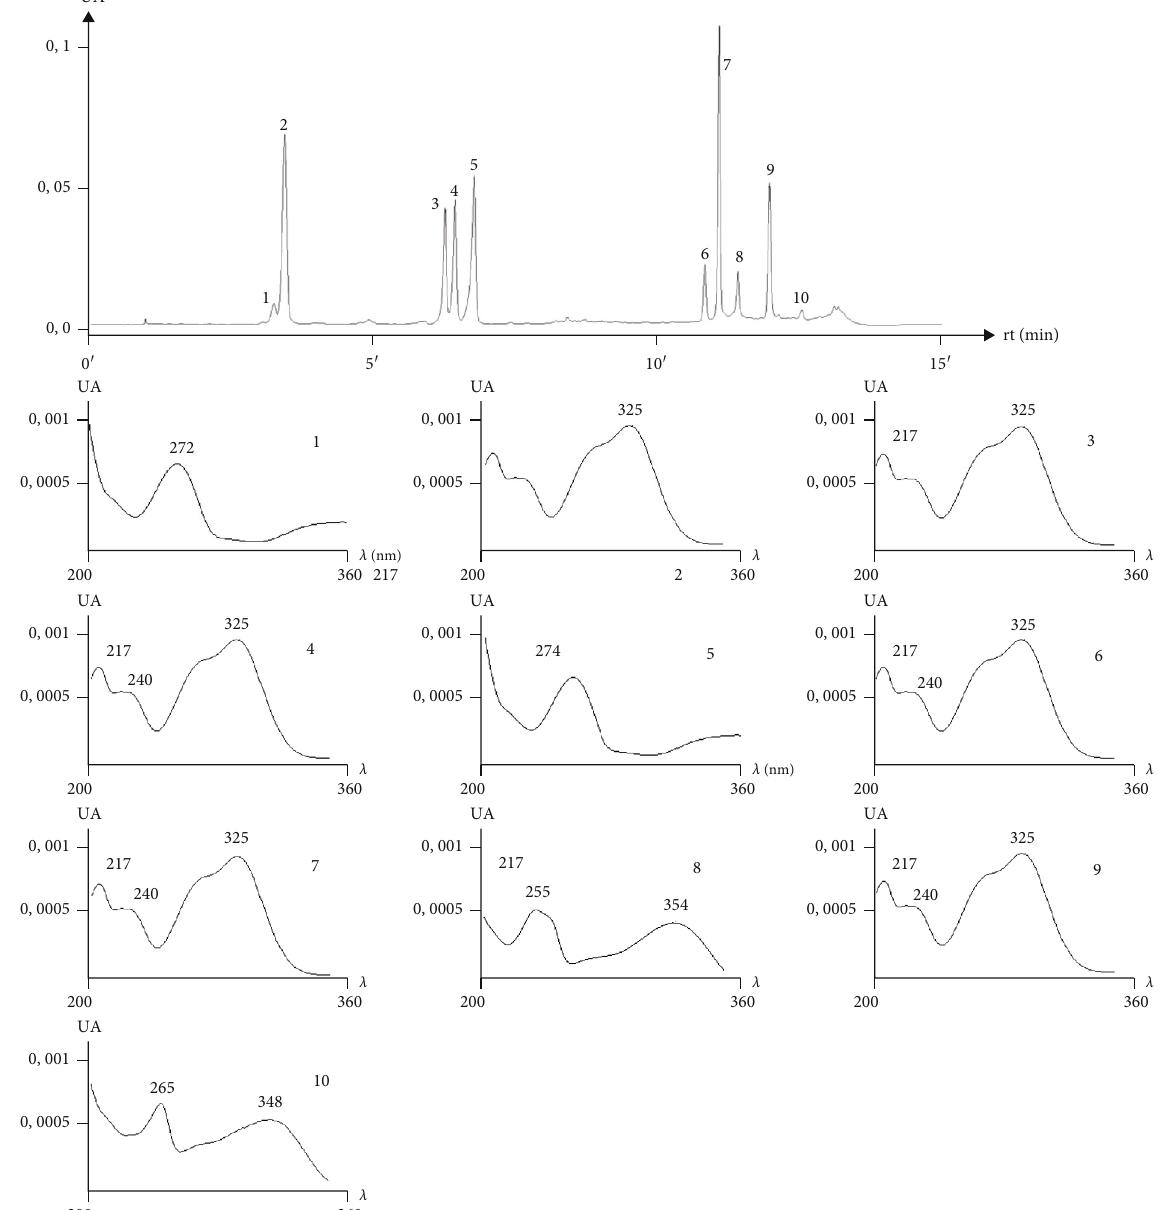
Figure 2: LC-UV chromatographic pro fi le at 270 nm and UV pro fi le of Ilex paraguariensis aqueous extract: (1) theobromine; (2) neochlorogenic acid; (3) cryptochlorogenic acid; (4) chlorogenic acid; (5) ca ff eine; (6) di-O-ca ff eoylquinic acid derivatives; (7) di-O- ca ff eoylquinic acid derivatives; (8) rutin; (9) di-O-ca ff eoylquinic acid derivatives; (10) not identi fi